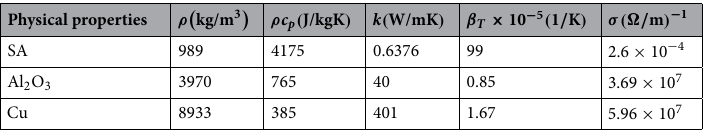
Table 1. Thermo-physical properties of base fluid and nanoparticles 14,31